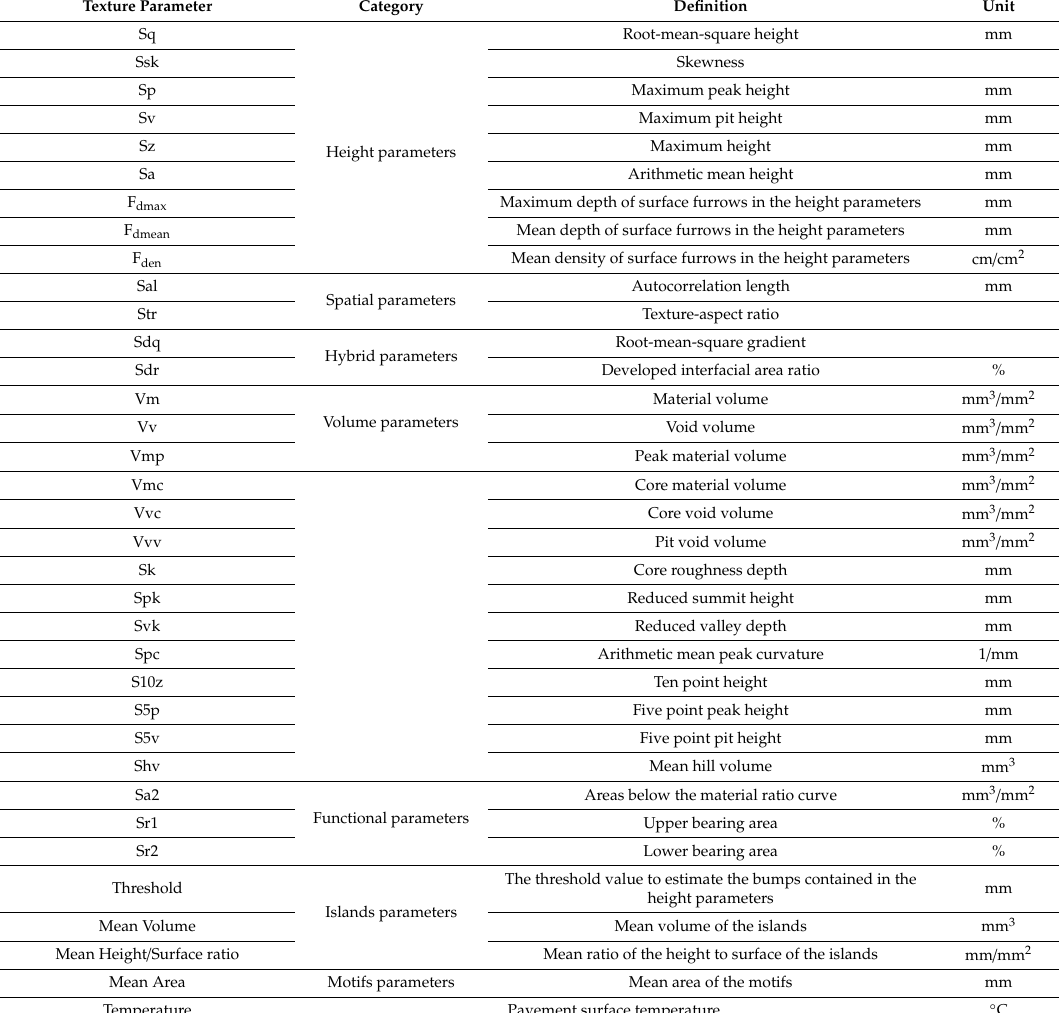
Table 3. 3D areal pavement texture parameters definition. Data from